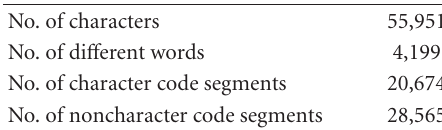
Table 1: Experiment data.